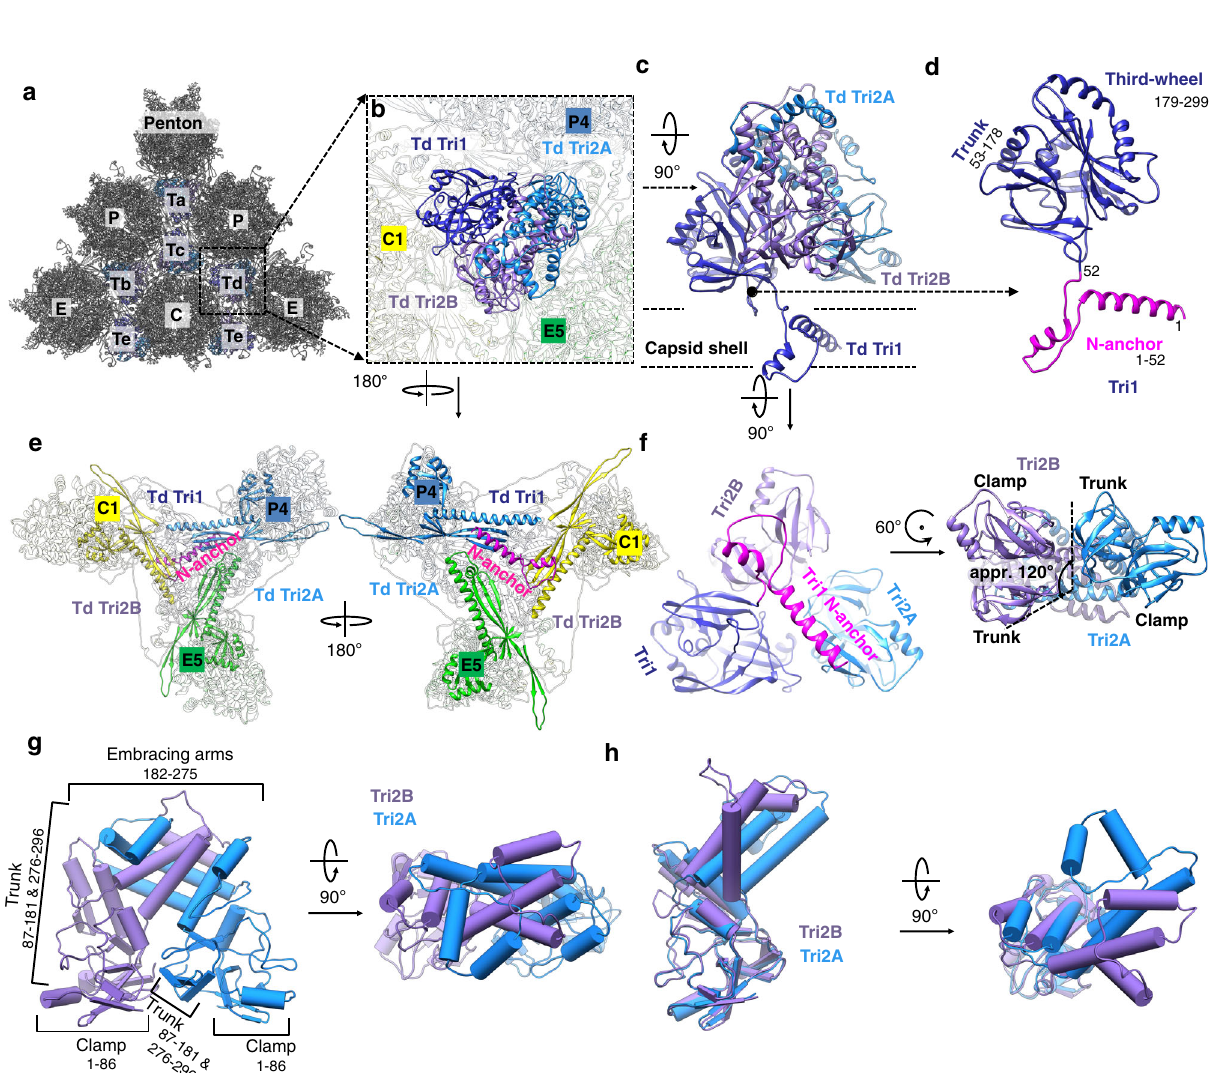
Fig. 3 Structure of triplex and the functional signi fi cance of Tri1 N-anchor. a Distribution of triplexes Ta, Tb, Tc, Td, and Te among three types of hexons (C, E, and P) and a penton. b Enlarged view of a triplex Td with three adjacent hexon MCP subunits labeled (C1, E5, and P4). MCP subunits have been faded. c Further enhanced structure of triplex Td, rotated 90 degrees clockwise on the x axis from b . d Model of Tri1 with labeled domains. e Top and bottom views of b , showing that triplex Td is anchored to the capsid fl oor by the “ V ” -shaped Tri1 N-anchor (in pink). f Triplex Td viewed from inside of the capsid (left), counterclockwise rotation of Tri2A by 120 degrees about a local threefold axis results in a superposition of clamp and trunk domains from Tri2A to those from Tri2B, suggesting a high level of similarity (right). g Pipe-and-plank representations of Tri2 dimer in side (left panel) and top (right panel) views showing the helix bundle formed from Tri2A and Tri2B ’ s embracing arm domains. h Two orthogonal views of superposition of Tri2A and Tri2B showing nearly identical clamp and trunk domains, but different embracing arms. See also Supplementary Movie between the two dimers, and these interactions bear no simila- Td, or Te in HHV-6B. The subunits of the pU11nt tetramers rities to one another. cluster on each triplex and lean against three neighboring pairs of Figure 4f – i and Supplementary Movie 7 show how a pU11nt MCP and SCP (Fig. 4f). Although the four pU11nt subunits have tetramer interacts with capsid proteins that rationalizes the highly similar structures, their interactions with neighboring binding of as many as four pU11nt subunits atop each triplex Tb, capsid proteins differ, exhibiting remarkable multi-speci fi cities in